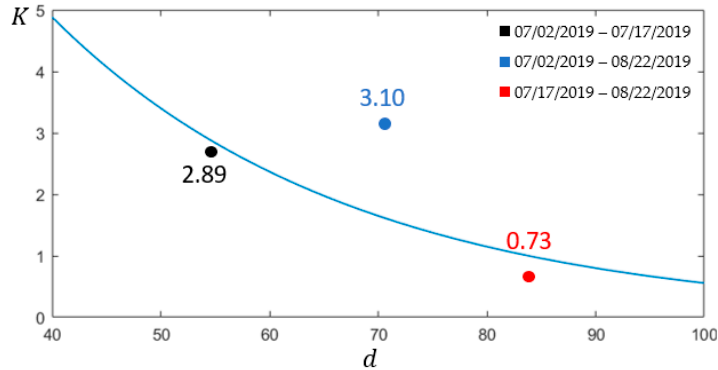
Figure 15. Correction factor ( K ) as a function of the corn phenology stage.